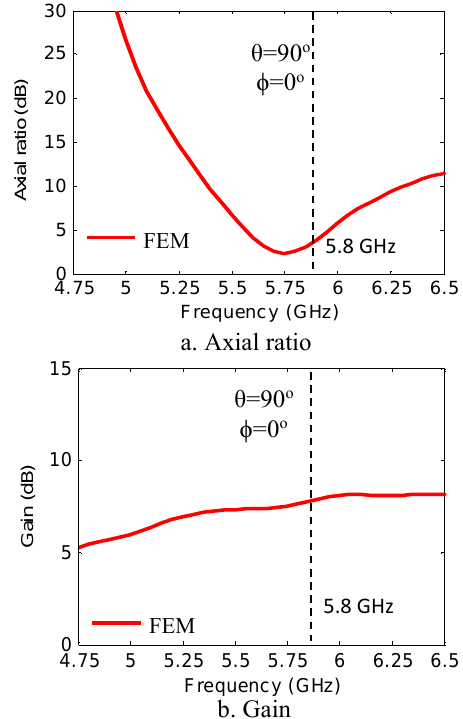
Fig.7. The gain and axial ratio of the circularly polarized DRA element mounted on a cylindrical ground plane placed inside a reader device and with the human hand model.